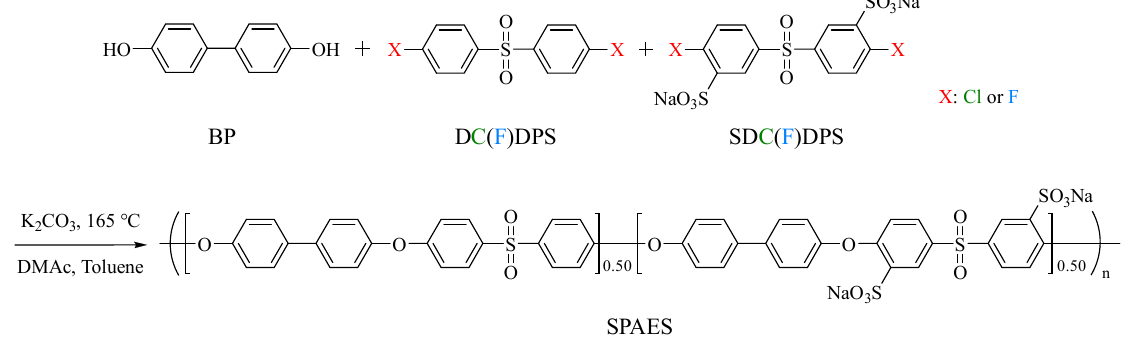
Figure 1. Synthesis scheme for the SPAES copolymer.